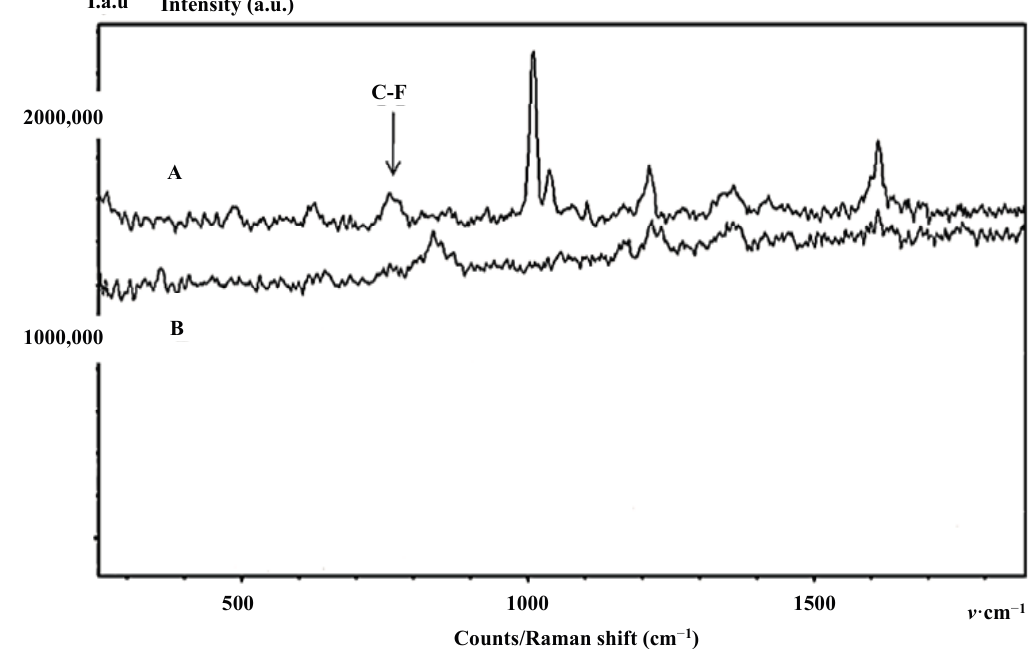
Figure 5. Background-Free Spectro-Fluor™ spectra of the purified and enriched protein of interest. Spectra in RIPA buffer of immune-precipitated p21 protein forms after (Time 24 h) effective incorporation of F-Phe ( A ) or non-labeled Phe. ( B ) 10 mg/mL of either amino-acid was added into McCoy’s 5a medium-containing HCT-116 colon cancer cells.